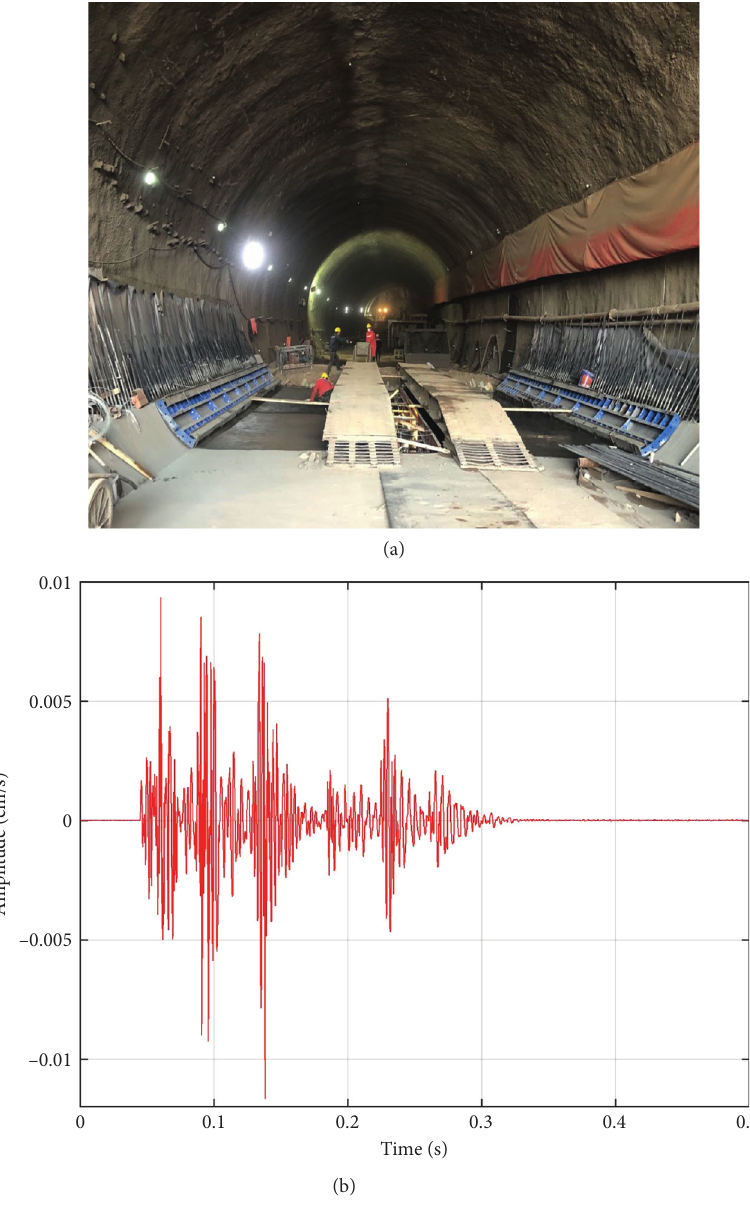
Figure 6: Underground tunnel blast vibration. (a) Blasting site of Nanjing metro line 3 tunnel. (b) Vibration signal.